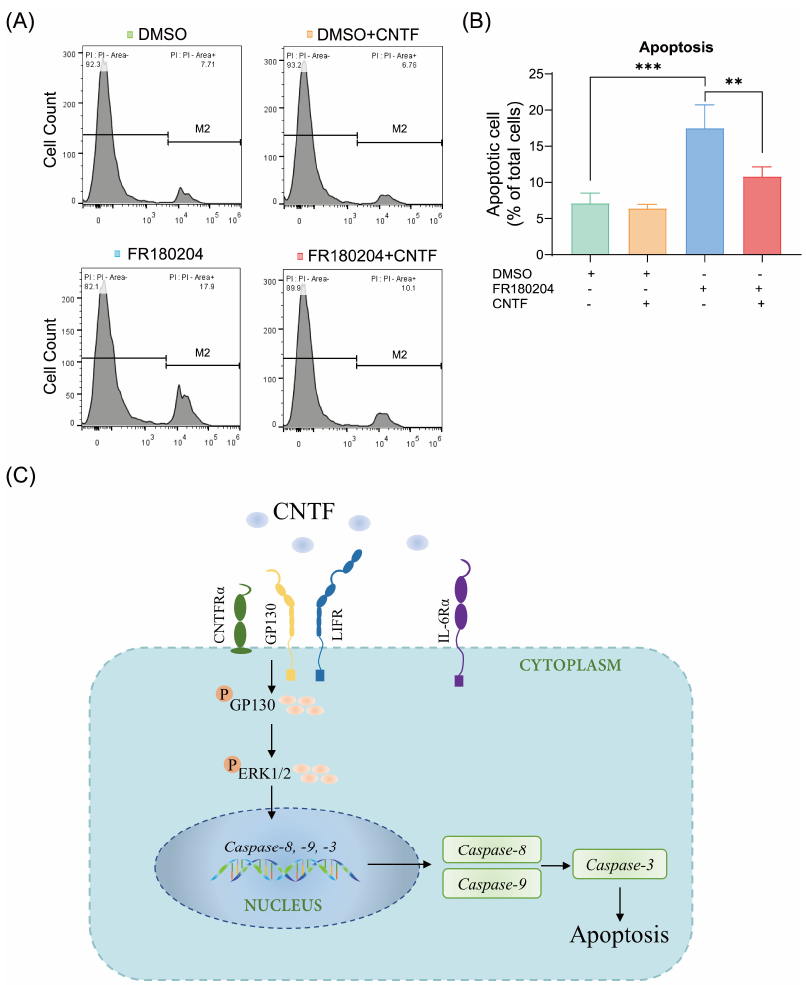
Figure 5. ERK1/2 signal is involved in the regulation of apoptosis of cementoblasts and the caspases pathway. ( A , B ) Graphics show the percentages of apoptotic cells exposed to ERK1/2